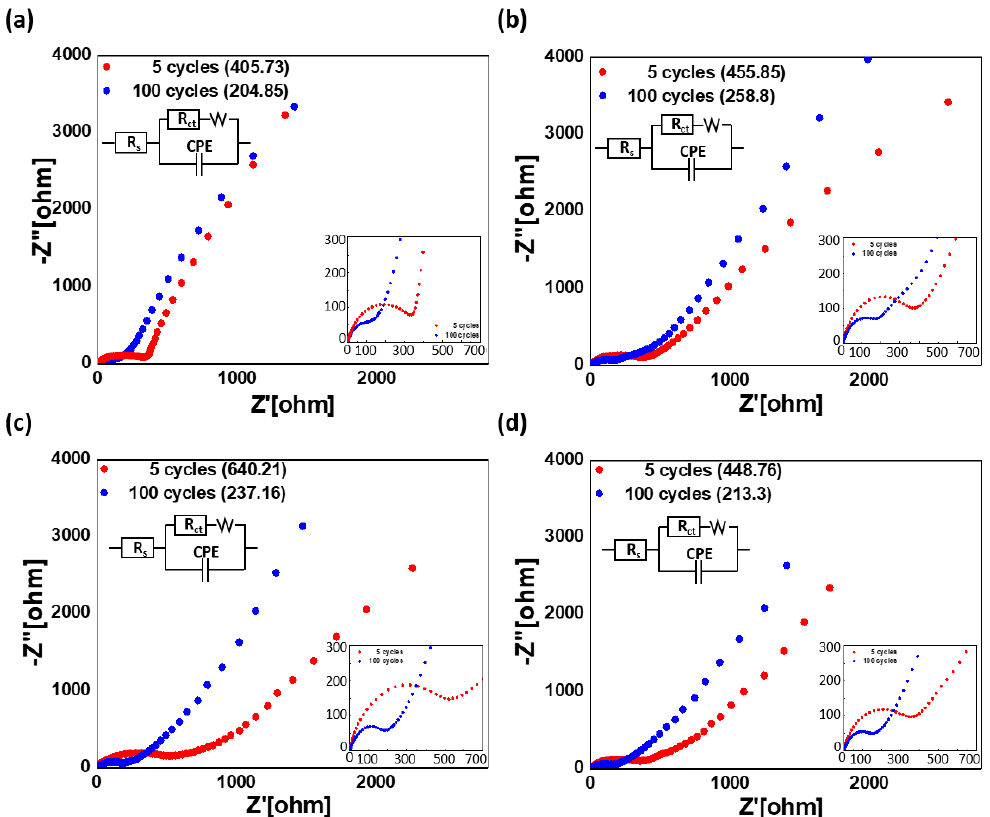
Figure 6. Data obtained by analyzing the impedance of the bare Cu current-collector and Cu current- collectors irradiated with laser after (5 and 100) cycles. Charge transfer resistance of ( a ) the bare Cu current-collector; and of the Cu current-collector irradiated with ( b ) 10 W; ( c ) 20 W; and ( d ) 30